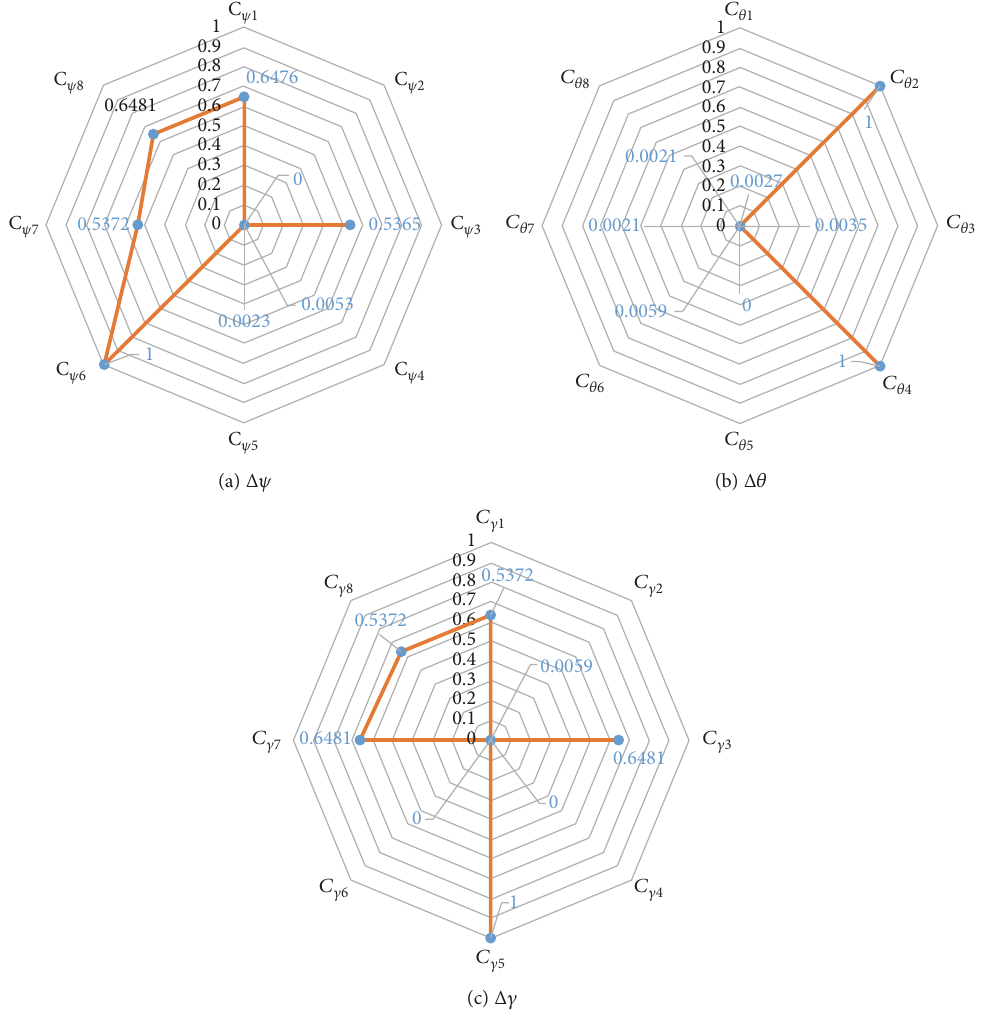
Figure 8: Sensitivities of orientation error to individual error